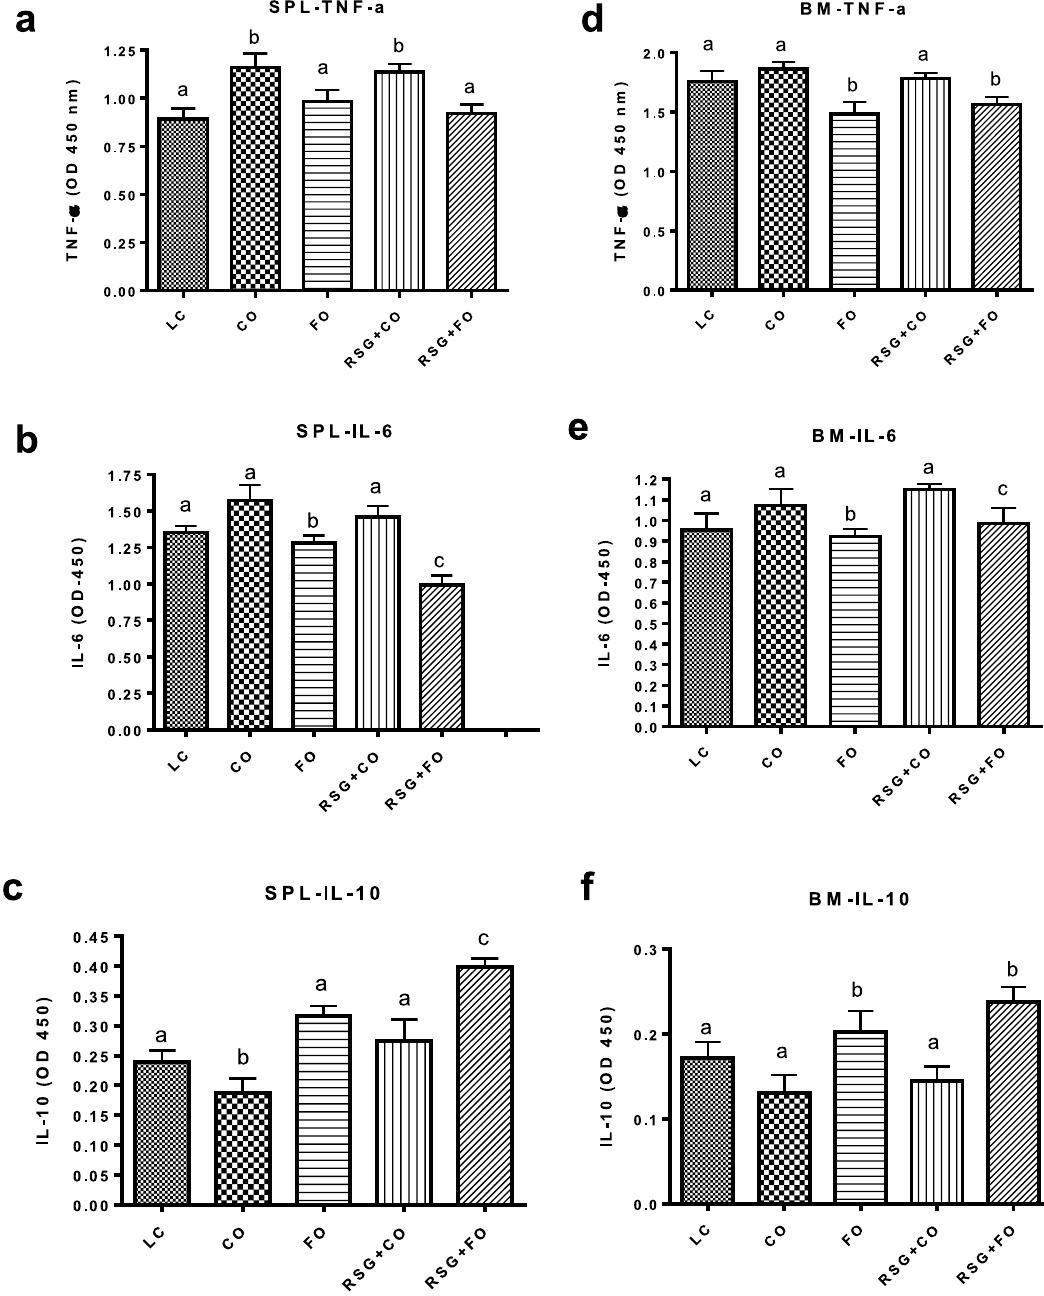
Figure 5. Effect of RSG with or without FO on inflammatory markers of aging C57BL/6 mice. Splenocytes and whole bone marrow (BM) cells were isolated from aging C57BL/6 mice on experimental diets: CO, RSG + CO, FO, RSG + FO, and LC for 5 months. Splenocytes ( a–c ) and BM cells ( d–f ) were cultured separately and treated with LPS for 24 h and culture supernatants were collected and analyzed for pro-inflammatory TNF-α, and IL-6 and anti-inflammatory IL-10 cytokines. n = 5 mice per group. Values with different letters are significantly different by one-way ANOVA followed by Newman-Keuls multiple comparison post hoc tests (p < 0.05). CO corn oil, RSG rosiglitazone, FO fish oil, LC lab chow, LPS Lipopolysaccharide, TNF‑α Tumor necrosis factor, IL‑6 Interleukin-6, IL‑10